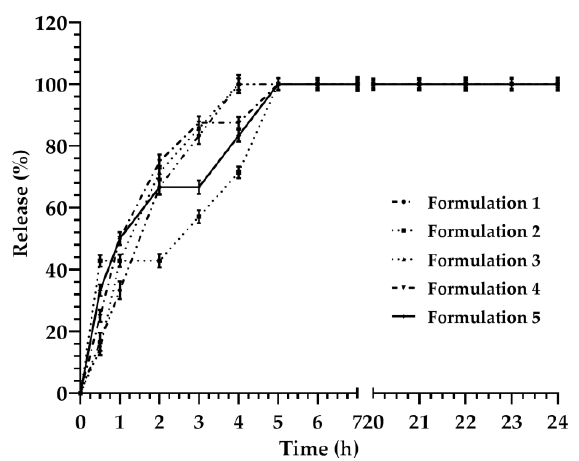
Figure 1. Release kinetic of fluorescein through lyotropic colloidal liquid crystal formulations. Lines and symbols, if not shown, are merged or filled in with those of other formulations. Data are the average of three different experiments ± standard deviation. Error bar if not shown is within the symbol.